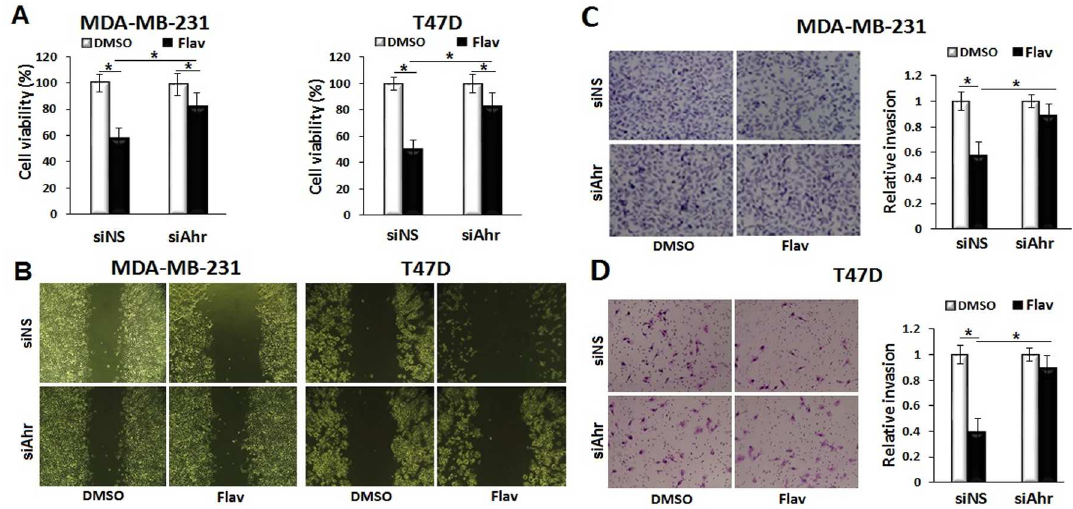
Fig 4. The inhibitory effects of Flavipin on breast cancer cells are Ahr-dependent. (A) The inhibitionof proliferation of MDA-MB-231 cells with Flavipin(200 μ mol/L)was mitigatedwith siAhr after 48 h treatment. The cells were transfected with siAhr or siNS by electroporation. Cell proliferation was quantifiedcalorimetrically at 540 nm using CCK-8 kit. (B) Depletionof Ahr by siAhr abrogatedthe inhibitoryeffects of Flavipin on migration of breast cancer cells. siAhr mitigatedthe inhibitory effects of Flavipin on invasionof (C) MDA-MB-231 and (D) T47D cells. Invasivenessof cancer cells were studied using Boyden chamber. The invadedcells were stained with Giemsa and countedin 4 different microscopicfields. Data are shown as mean ± SD from representative experiment studied in triplicates. * P <